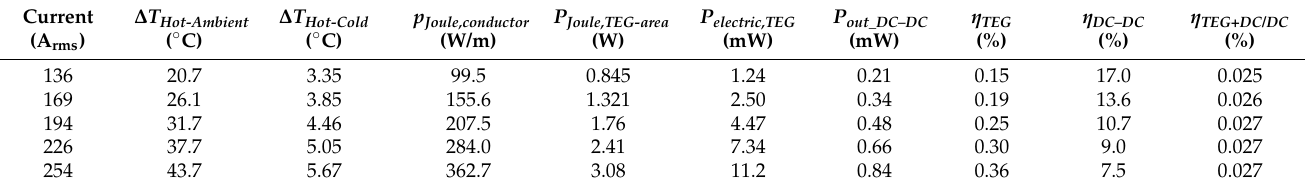
Table 2. Power and efficiency of the TEGs and DC–DC converter when the busbar reaches the steady state